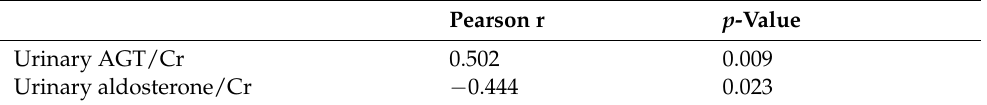
Table 2. Correlation of urinary angiotensinogen and aldosterone to proteinuria. Pearson r p